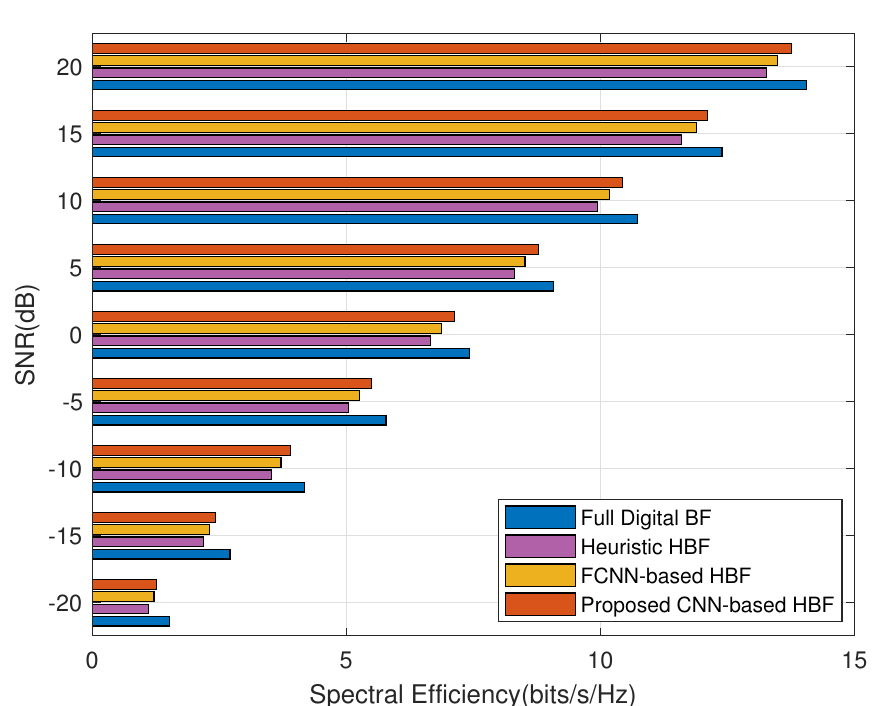
Figure 10. Comparison of spectral efficiency performance under different schemes in geometric mmWave channel with N t =